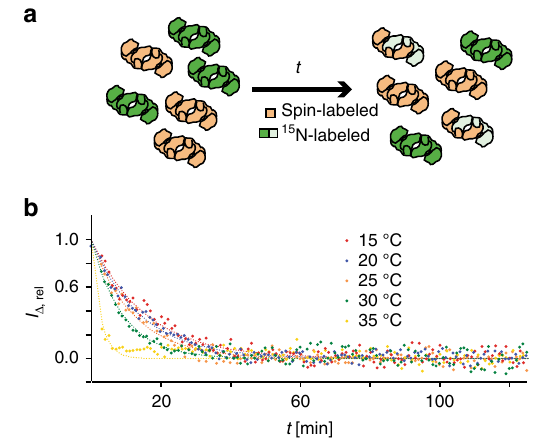
Fig. 3 Determination of the lifetime of the TF dimer. a Experimental scheme. At the onset of the experiment ( t = 0), separately produced samples of [ U - 15 N, 2 H]-labeled (green) and randomly spin-labeled (brown) TF are mixed in equal ratio in sample buffer (left). The NMR signal intensity is then monitored in real time t during the equilibration to the end point (right). NMR signals of protomers bound to a spin-labeled protomer are reduced in intensity by the intermolecular PRE, symbolized by light green color. b Intensity of 15 N- fi ltered NMR signals, I Δ , rel , following the experimental scheme in a . The lifetime of the TF dimer is obtained by non- linear least-square fi ts (lines) to the data (dots). See Supplementary Note 1 for mathematical details. The experiment was performed at fi ve temperatures in the range 15 – 35 °C, as